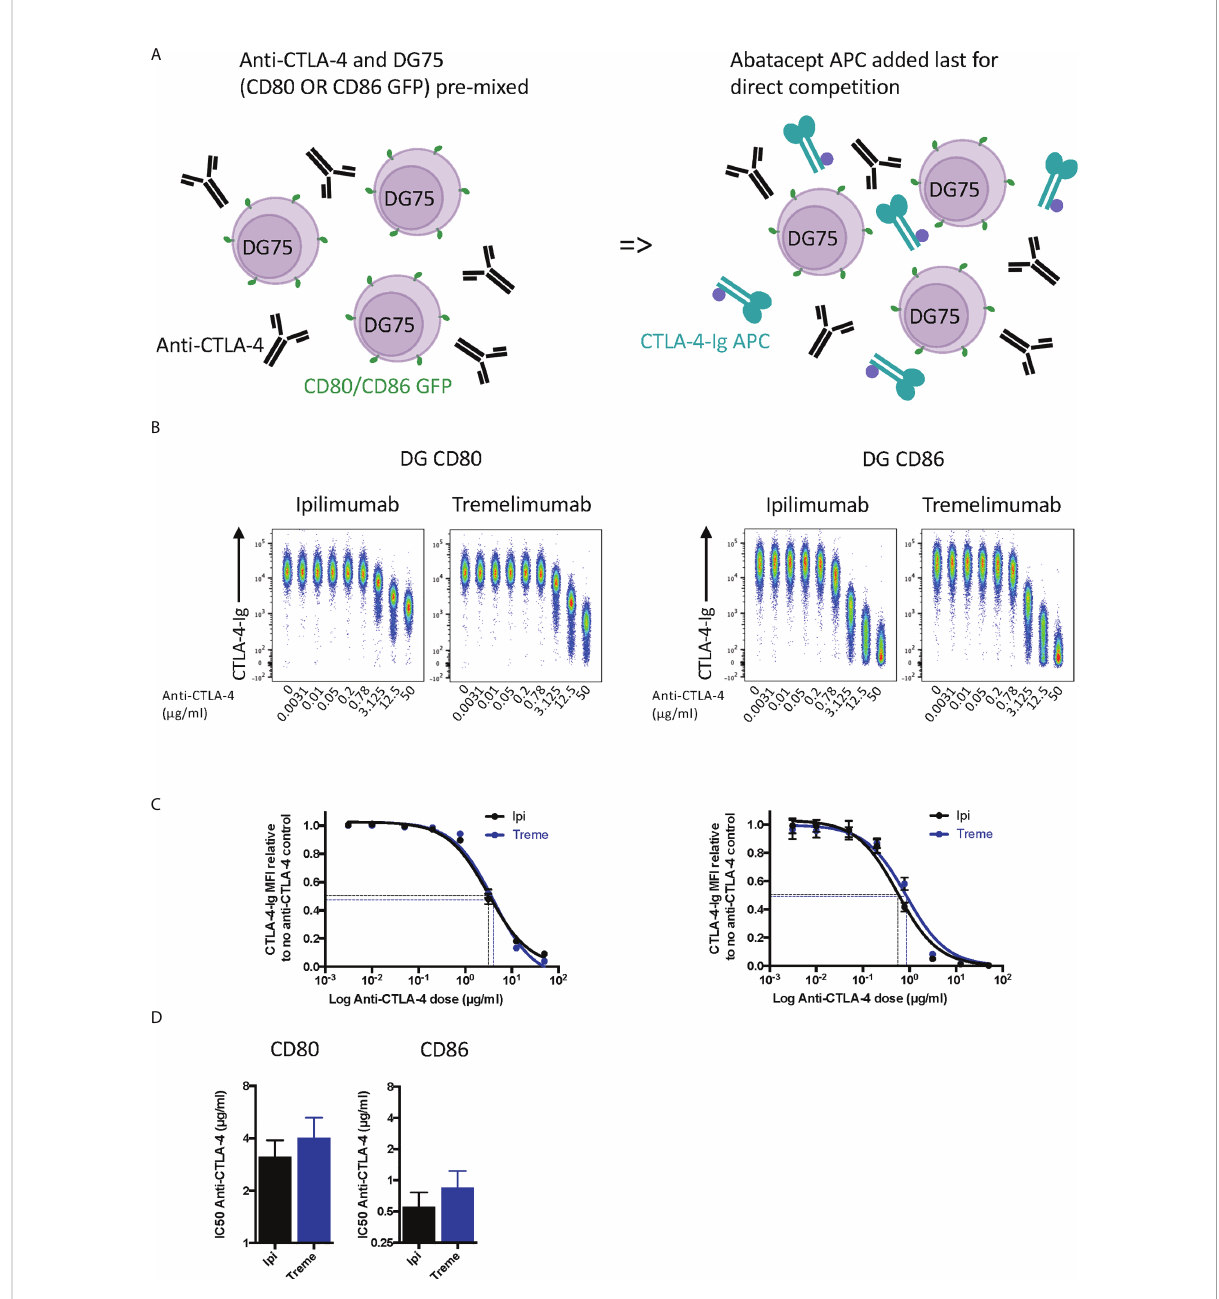
FIGURE 2 Ipilimumab and Tremelimumab outcompete cell bound CD80 or CD86 for engagement with soluble CTLA-4-Ig. (A) Schematic of experimental set-up. DG75 B cells expressing either CD80 or CD86-GFP were mixed with a titration of soluble anti-CTLA-4 Abs. A fi xed dose (2µg/ml) of soluble APC conjugated Abatacept was added to assess direct competition between soluble anti-CTLA-4 and cell bound ligand for Abatacept binding. Cells were incubated on ice, washed and Abatacept-ligand engagement analysed by fl ow cytometry. All reagents/cells were chilled on ice before use. (B) Concatenated FACS plots show reduced Abatacept-ligand engagement as the dose of anti-CTLA-4 Abs increased. (C) Anti- CTLA-4 doses were Log(x) transformed and dose response curves fi tted using Prism v6 to obtain Log IC 50 for ipilimumab (Black line) and tremelimumab (Blue line). (D) Graphs show the mean IC 50 with 95% con fi dence interval calculated using Prism v6. Data for ipilimumab and tremelimumab were acquired in separate 96-well plates and data presented as mean +/- SD from 3 independent